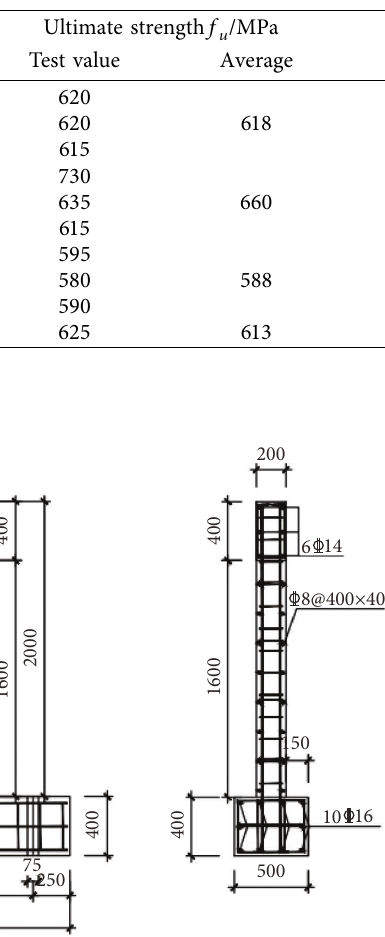
Table 1: Mechanical properties of